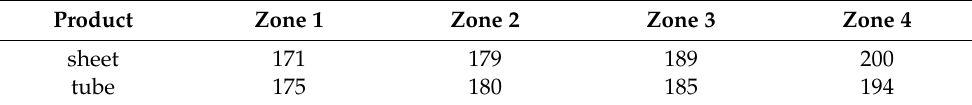
Table 1. Barrel temperature setting for processing poly (l-lactic acid) (PLLA) sheets and tubes (Unit: ◦ C).